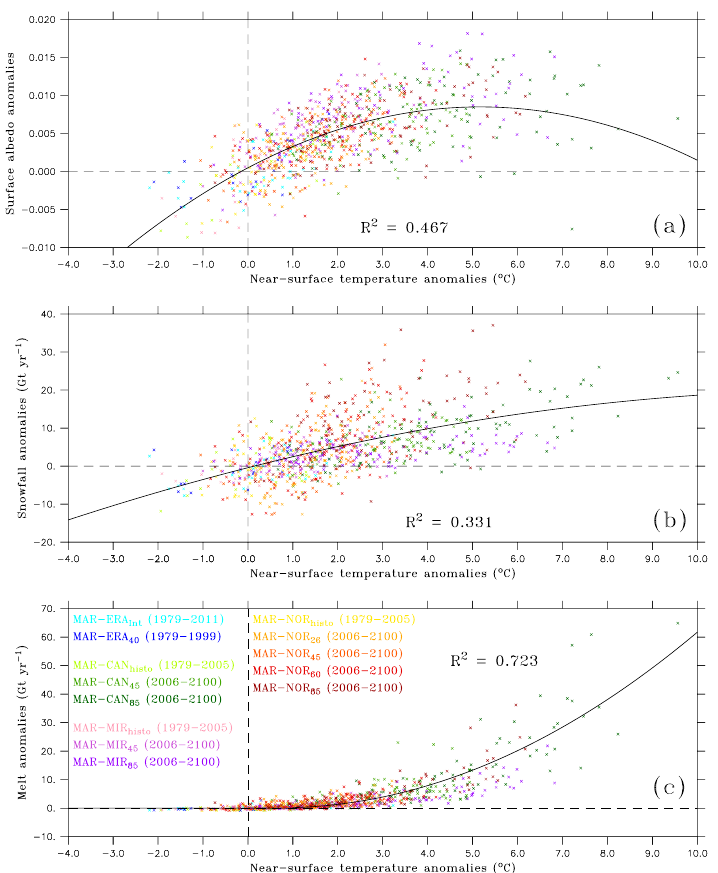
Fig. 7. (a) Summer (from May to September) surface albedo anomalies according to the summer near-surface air temperature anomalies ( ◦ C) over the central ice sheet (MSK centre ) for the MAR simulations forced by the reanalyses and the CMIP5 GCMs, with regression drawn in a solid black line. All the summer anomalies are related to the 1980–1999 average outputs provided by MAR forced with the same forcing fields. (b) The same as (a) , but for the summer snowfall anomalies (Gtyr − 1 ) on MSK centre . (c) The same as (b) , but for the summer melt anomalies (Gtyr − 1 ) on MSK centre